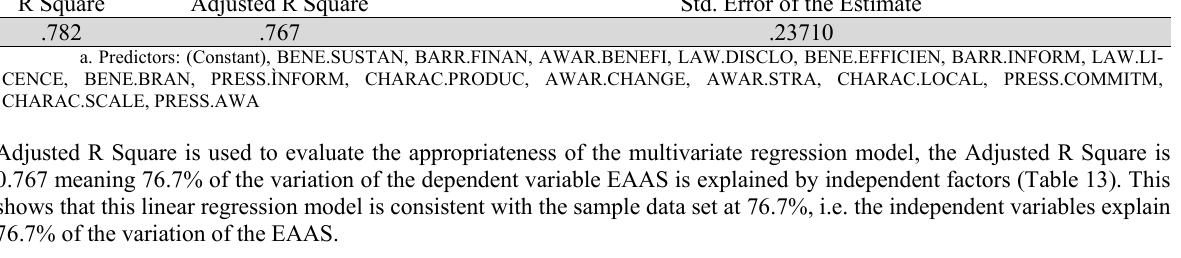
The results of ANOVA test Model Sum of df Mean Square F Sig. Regression 46.906 Residual 13.098 1 Total